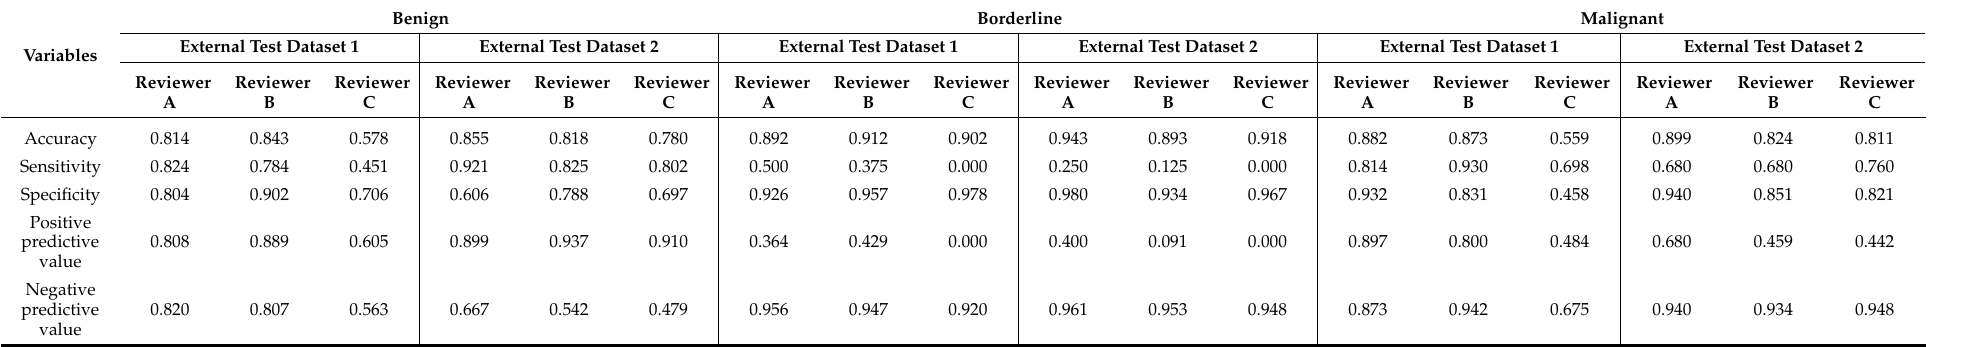
Table 4. Diagnostic performance of sonographers using external test